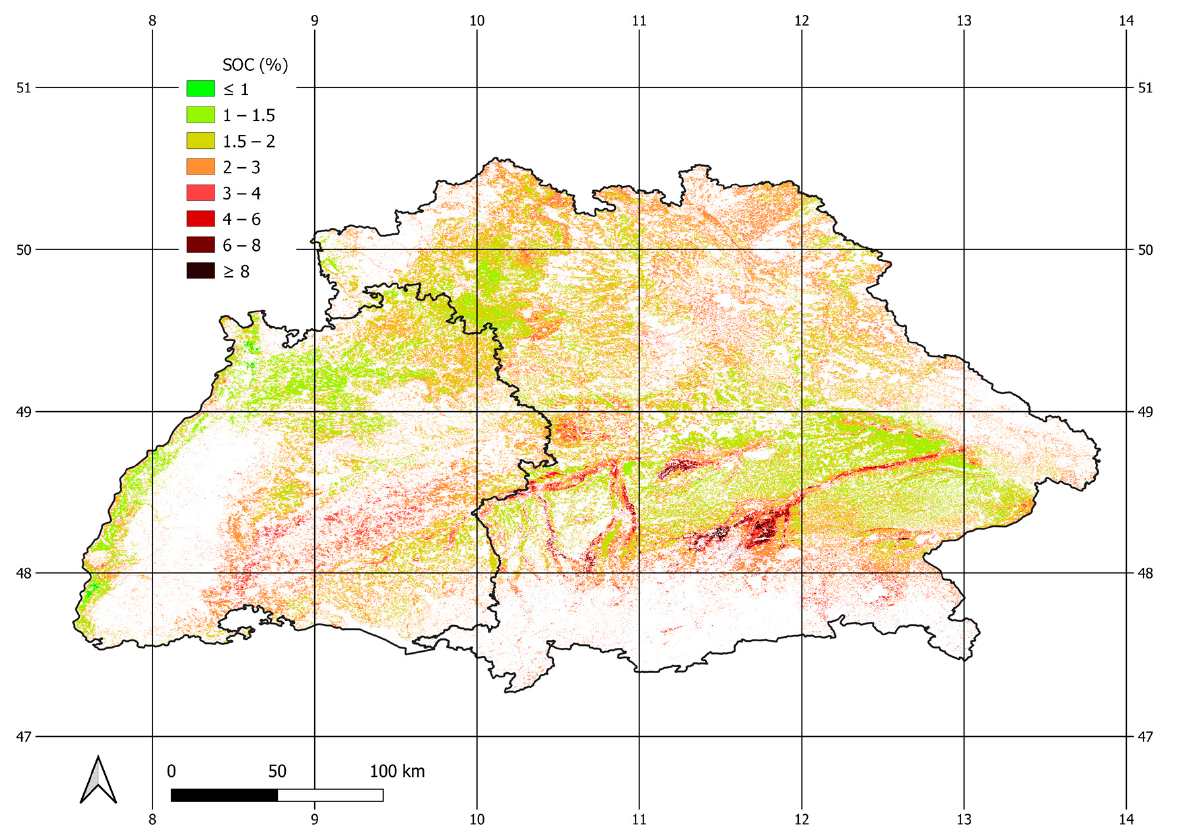
Figure 8. Final SOC map. Values were predicted for BY and BW independently, using the combined models of the respective state.